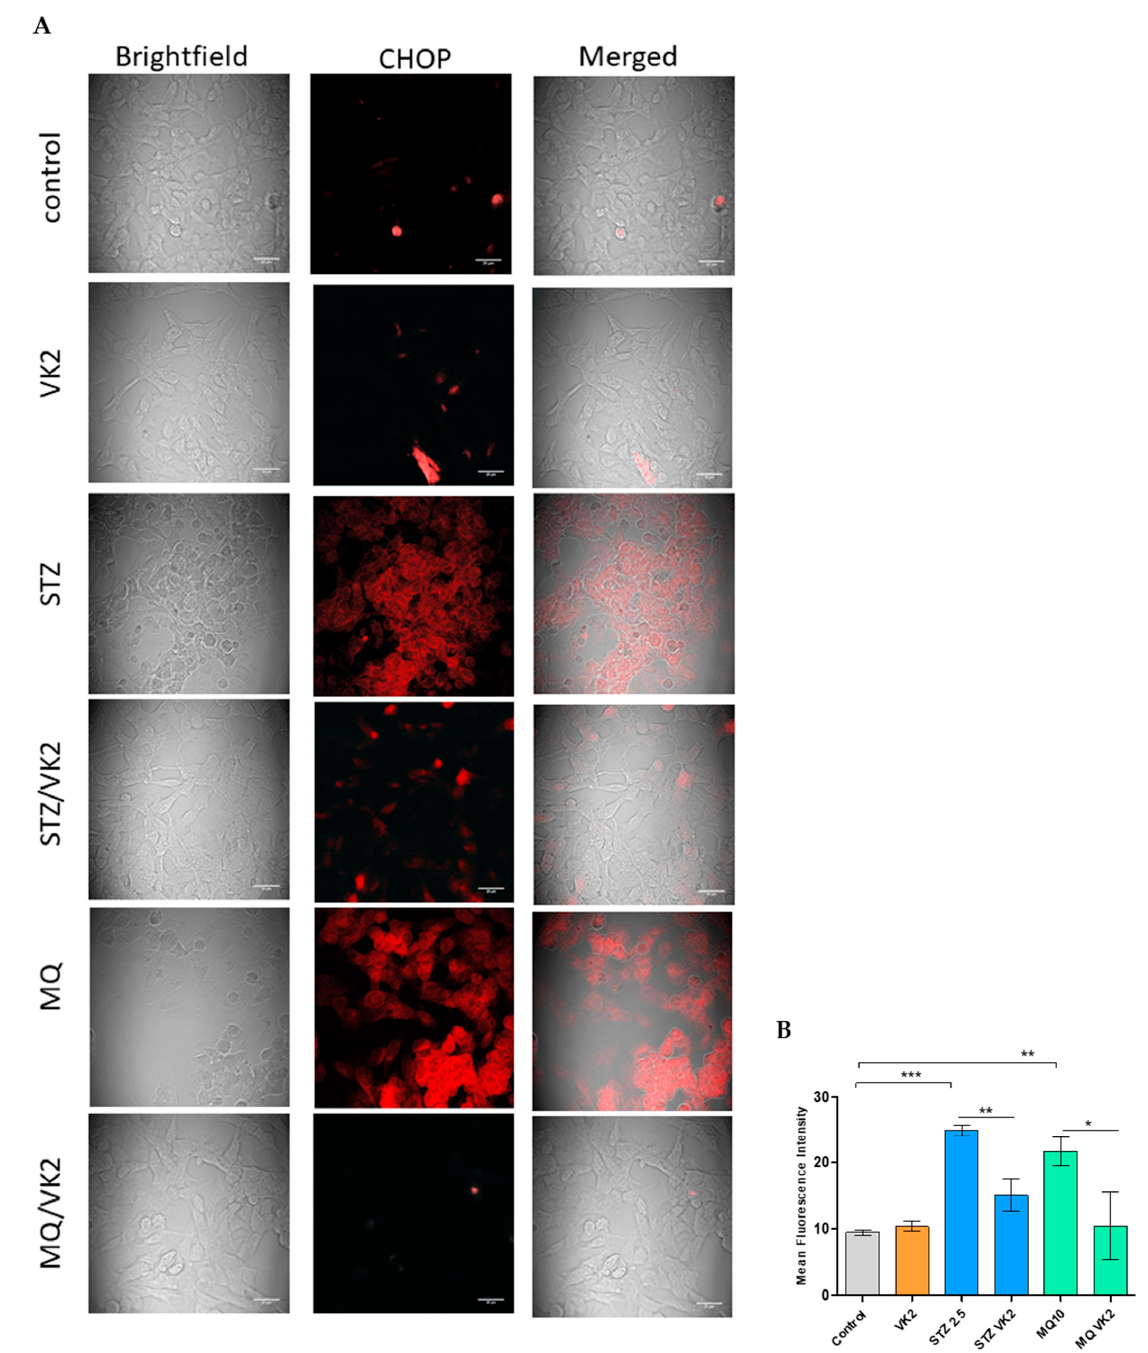
Figure 5. Determination of CHOP expression by immunofluorescence staining using confocal microscopy. ( A ) Images of human SH-SY5Y neuroblastoma cells were taken after streptozotocin and menadione (MQ) exposure and post-treatment with vitamin K2. All images were taken with a 63× oil objective. Images were taken in brightfield and Texas red modes, where AF568 (red staining) represents CHOP. Further merged images were used to observe the differences among the control, only VK2, streptozotocin (2.5 mM), and its post-treatment with vitamin K2 (50 µM); menadione (10 µM) and its post-treatment with vitamin K2 (50 µM). ( B ) Representative graphs of the mean fluorescence intensity from three different fields of view using ImageJ software. The data are presented as mean ± SEM. Statistical analysis was performed using Student’s t -test and differences with p -values ≤ 0.05 were designated as significant. * p < 0.05, ** p < 0.01, and *** p < 0.001 denote significant differences compared to the control and between the treatment groups. [STZ—streptozotocin; VK2— vitamin K2; STZ/VK2—post-treatment of streptozotocin (2.5 mM)-treated cells with vitamin K2 (50 µ M); MQ—menadione; MQ/VK2—post-treatment of menadione (10 µ M)-treated cells with vitamin K2 (50 µ